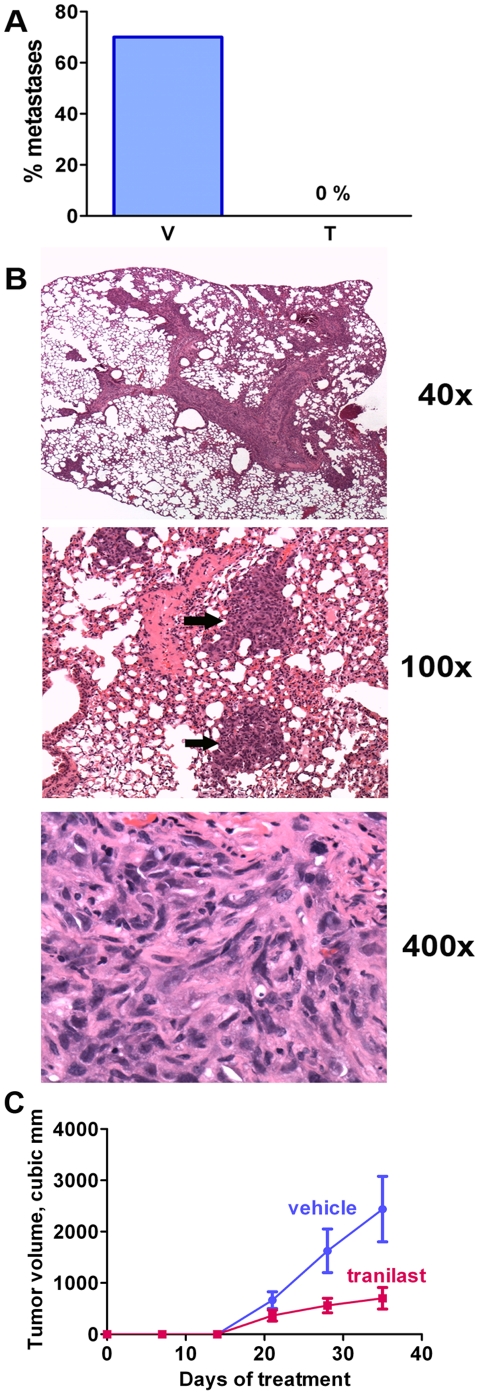
Tranilast prevents breast cancer metastasis in a xenotransplantation model.A. NOD scid gamma mice received a single i.v. injection of MDA-MB-231-derived D-CSCs (150,000 cells; day 0), and were treated with either vehicle (V) or tranilast (T; 300 mg/kg/d) from day -1 to day 21. The mice were terminated on day 28 and the lungs were examined. Lung metastases were observed in the majority of vehicle-treated mice, but there was not a single metastasis in the tranilast-treated group. n = 10 mice/group. p = 0.0015 by Fisher's exact test comparing the number of mice with metastases in each group. B. Metastases in the lungs of a vehicle-treated mouse (H & E staining of histological slide). The arrows indicate metastatic tumor foci. C. Inhibition of the growth of primary tumors in the mammary fat pad. 20,000 D-CSC cells were injected in a mammary fat pad at day 0. Mice were treated with 300 mg/kg/d tranilast or vehicle, starting at d 0. Tumors were examined as described [12] and volume  =  length X (width X width)/2, +/− SEM (n = 7; p<0.05 for tranilast versus vehicle).